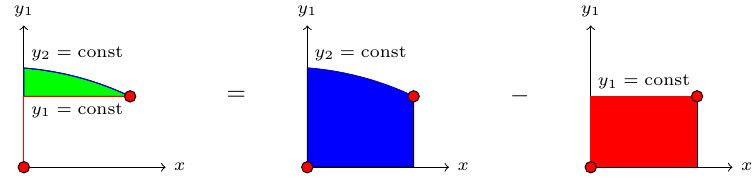
Figure 4: The difference of two integration paths defines an area (green), which we write may write as the difference of two areas, where each area only knows about one integration